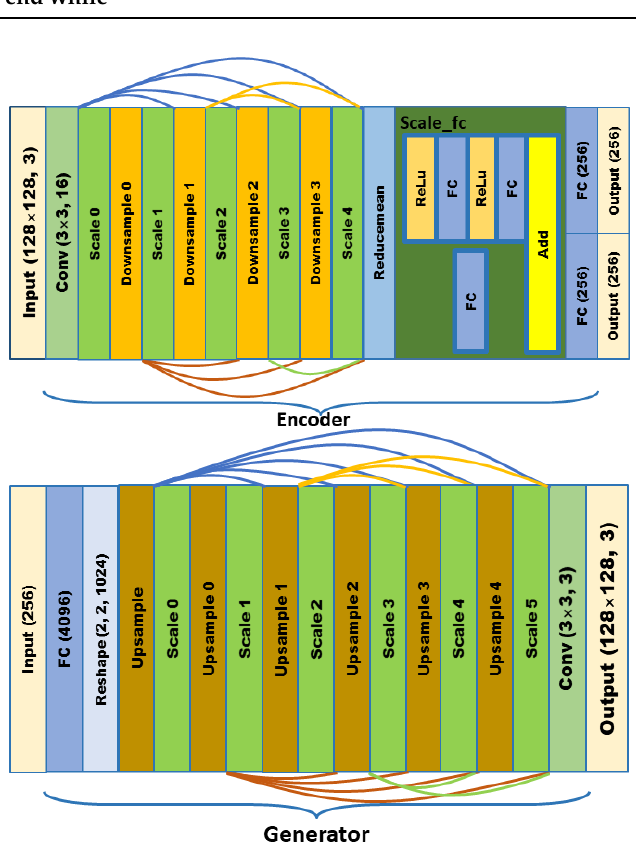
Figure 9. Dense connection strategy in the encoder and generator.